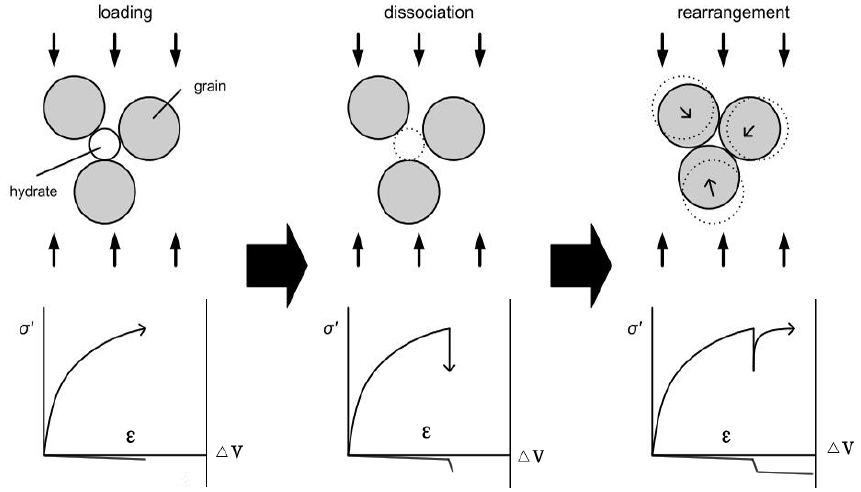
Figure 7. Schematic diagram of the mechanical influence of hydrate decomposition in the sediments (modified from Uchida S [27]).